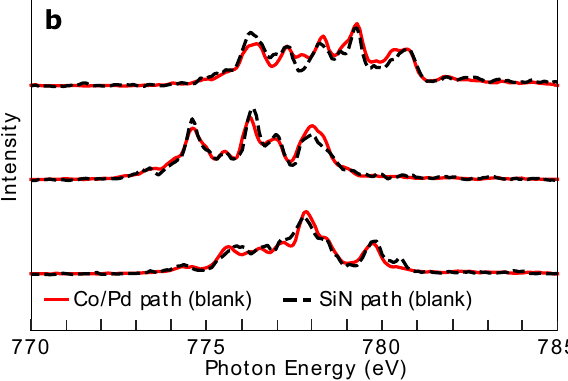
Fig. 1 Experimental setup. a Simpli fi ed schematic of the experimental setup, which was also used in Chen et al. 23 . Linearly polarized Self- Ampli fi ed Spontaneous Emission (SASE) X-ray pulses are produced by an X-ray free electron laser. The X-ray pulses are split into two components with an X-ray beam splitter. One of the resultant X-ray beams passes through a blank SiN membrane while the other passes through a membrane with a Co/Pd magnetic multilayer. The beams emerging from the membranes in the forward direction are measured with a grating-based spectrometer which uses a Charge-Coupled Device (CCD) for photon detection. b Examples of single-shot spectra for a 25 fs pulse, recorded when the membranes and Co/Pd multilayers were removed from the X-ray paths. The spectra recorded from each beam align very well, demonstrating our ability to normalize the Co/Pd multilayer spectra by the bare membrane reference